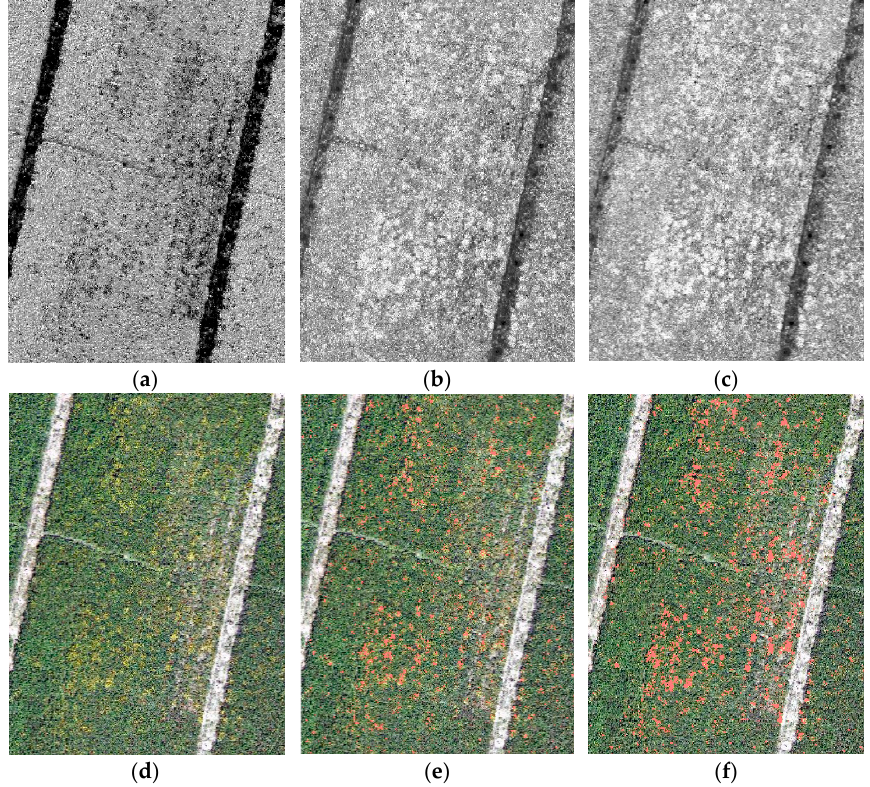
Figure 2 . Comparison among ( a ) Normalized Difference Vegetation Index (NDVI); ( b ) (R − B)/(R+B) and ( c ) (R − B)/(R+B+G) indices calculated on a weed-infested part (2000 m 2 ) of the alfalfa plot; ( d ) RGB image of the same area; ( e , f ) corresponding weed classification results ( orange ) from the models based on NDVI and (R − B)/(R+B) indices, and on NDVI and (R − B)/(R+B+G) indices, respectively, shown on top of the RGB image.